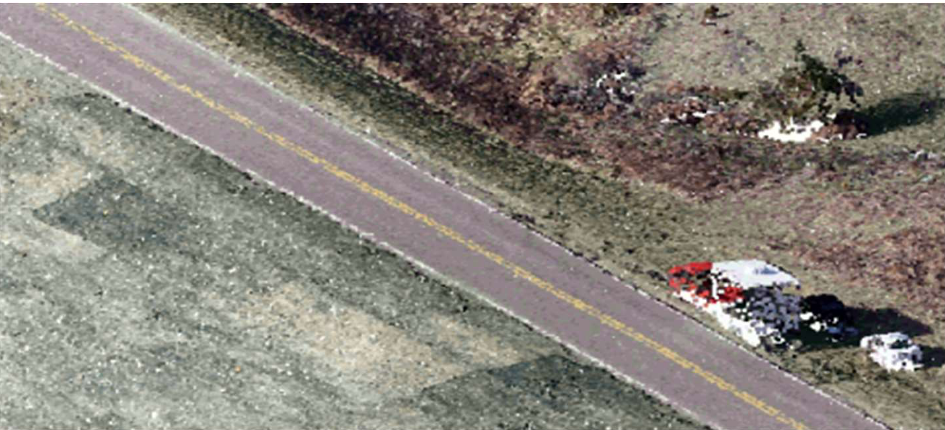
Figure 3. Example view of a point cloud as collected from a UAS platform.